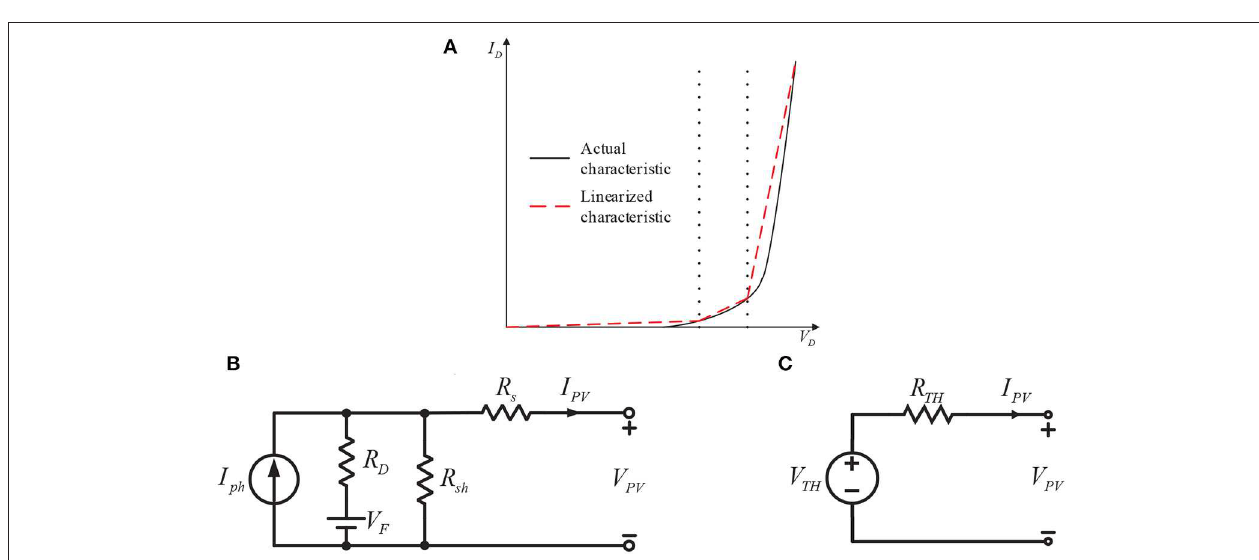
FIGURE 2 | (A) Voltage-current characteristic of diode showing actual characteristic and the piecewise linearized characteristic; (B) Equivalent PV model with diode voltage drop V D and diode resistance R D ; (C) Thevenin equivalent circuit of PV source.